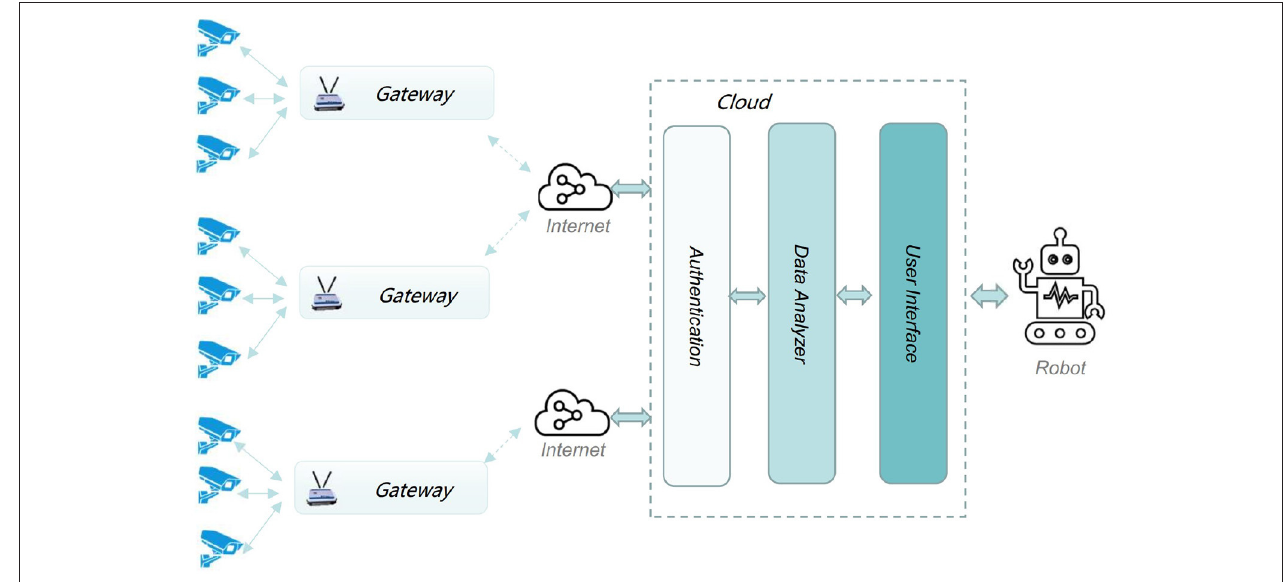
FIGURE 1 | Layout of intelligent security robot applications.